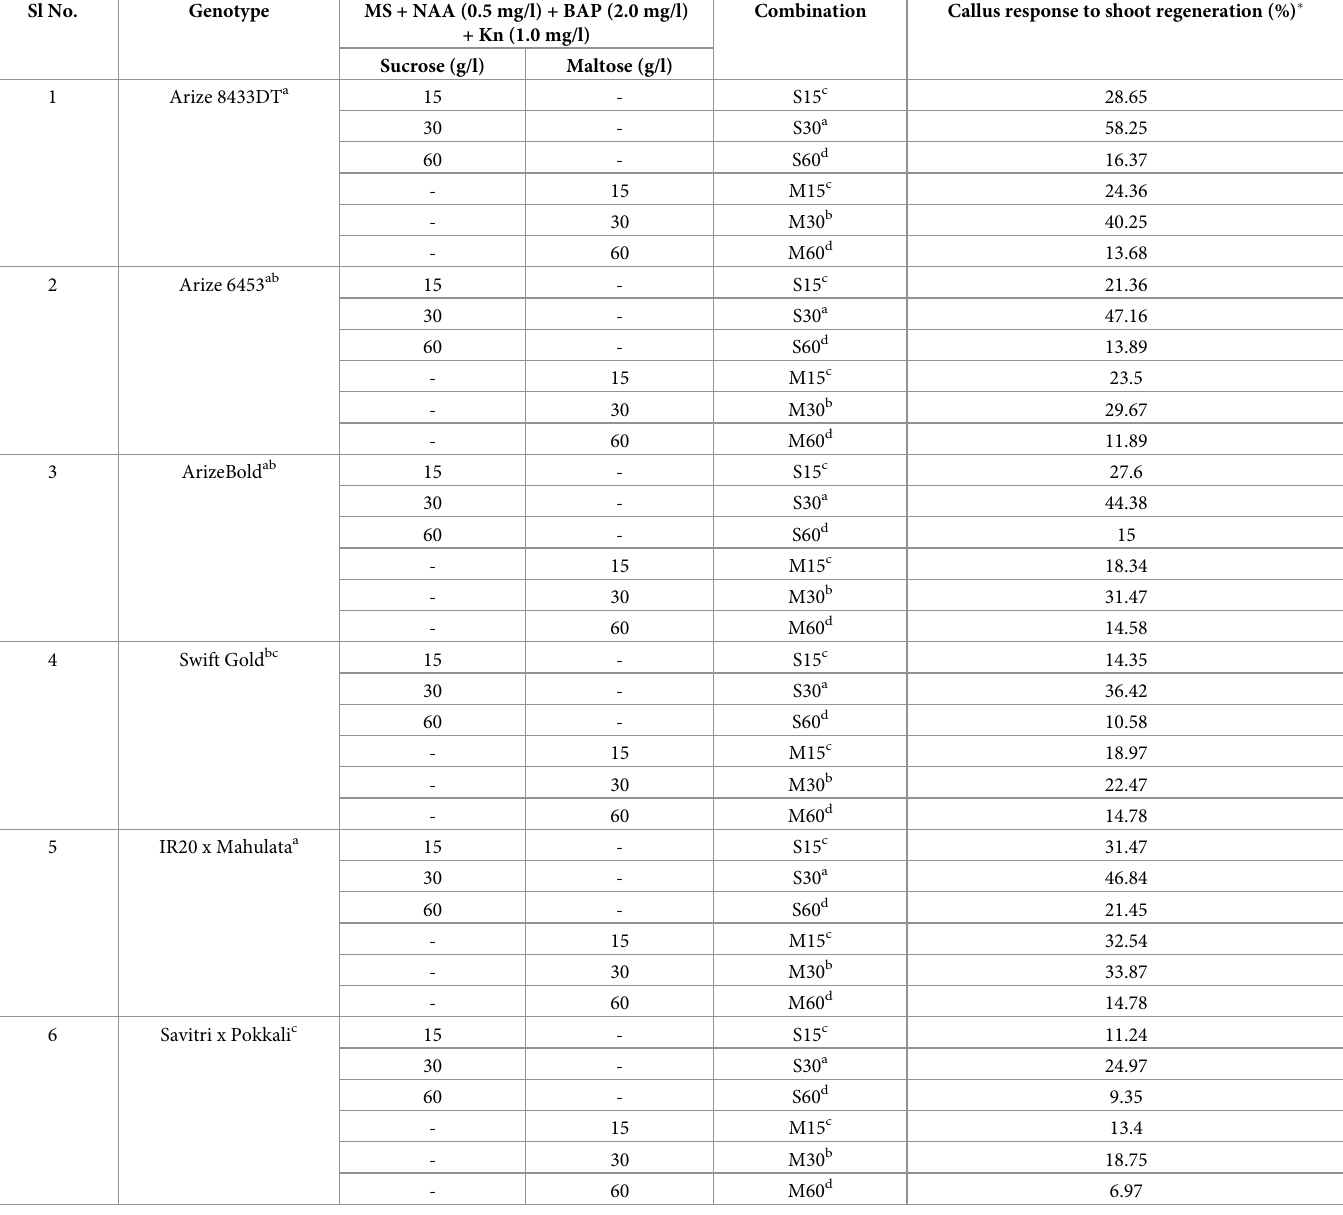
Means sharing the same letter in a column were not significantly different in Duncan’s multiple comparison range test (p < 0.05). � 10 replicates per treatment; repeated